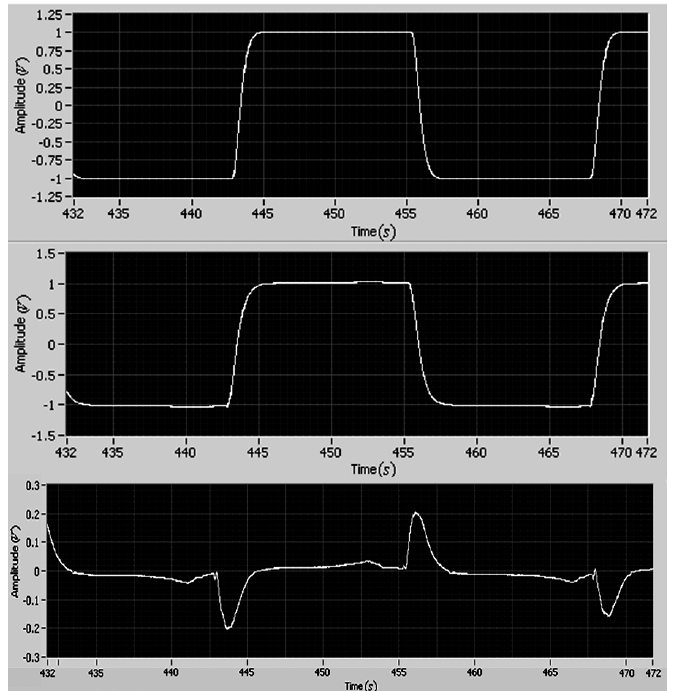
(middle) and (bottom) ,